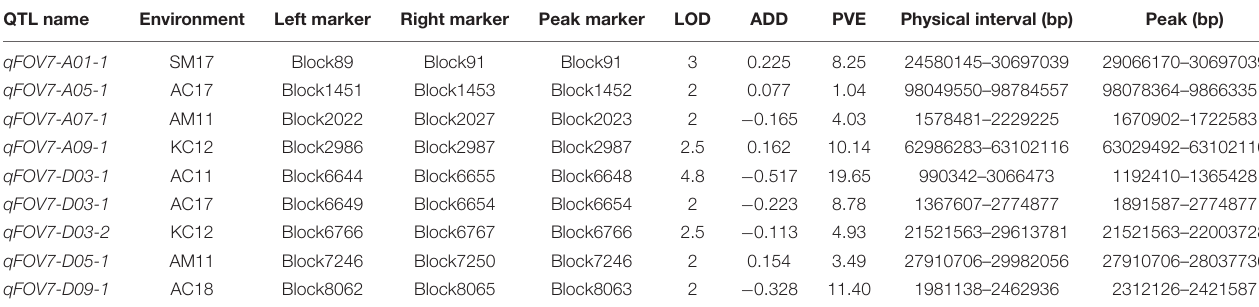
TABLE 4 | Summary of FOV7 resistance QTLs identified in different environments.